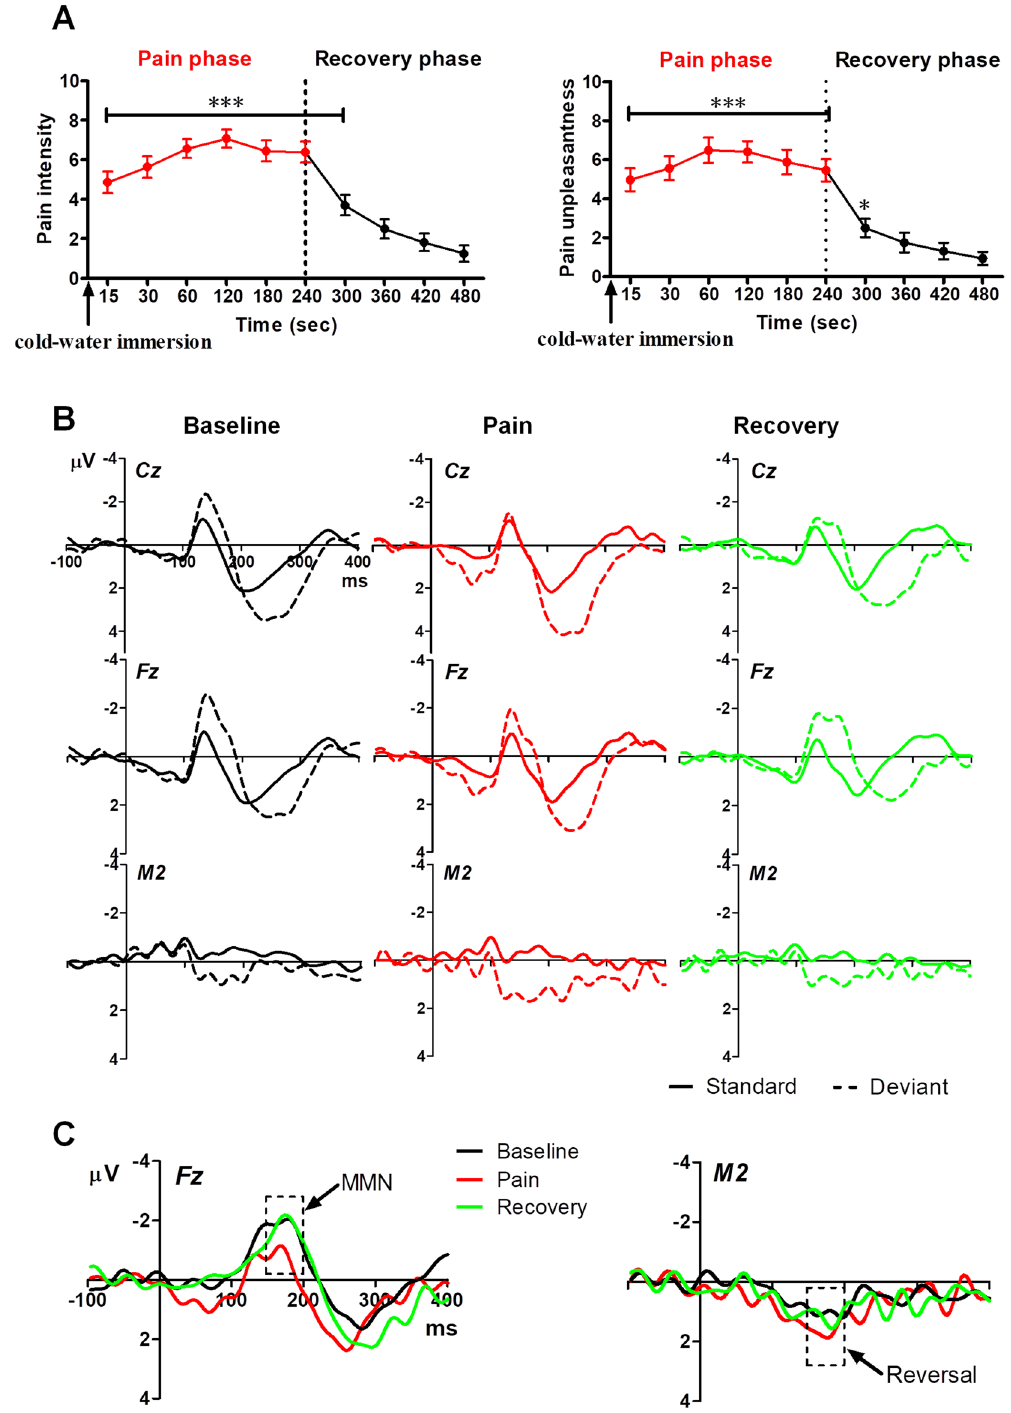
Figure 4. ERPs produced in response to standard and deviant tones and MMN grand average waveforms in Experiment 2. ( A ) Ratings of pain intensity and unpleasantness in cold-induced pain (red) and recovery (black) phases. * P < 0 . 05 , *** P < 0 . 001 , compared to ratings at 480 s. ( B ) Grand average waveforms generated in response to standard and deviant tones in the baseline (black), cold pain (red), and recovery (green) periods. ( C ) MMN grand average waveforms in different experimental phases. The dashed boxes superimposed on the waveforms mark the time window of the MMN (150–200